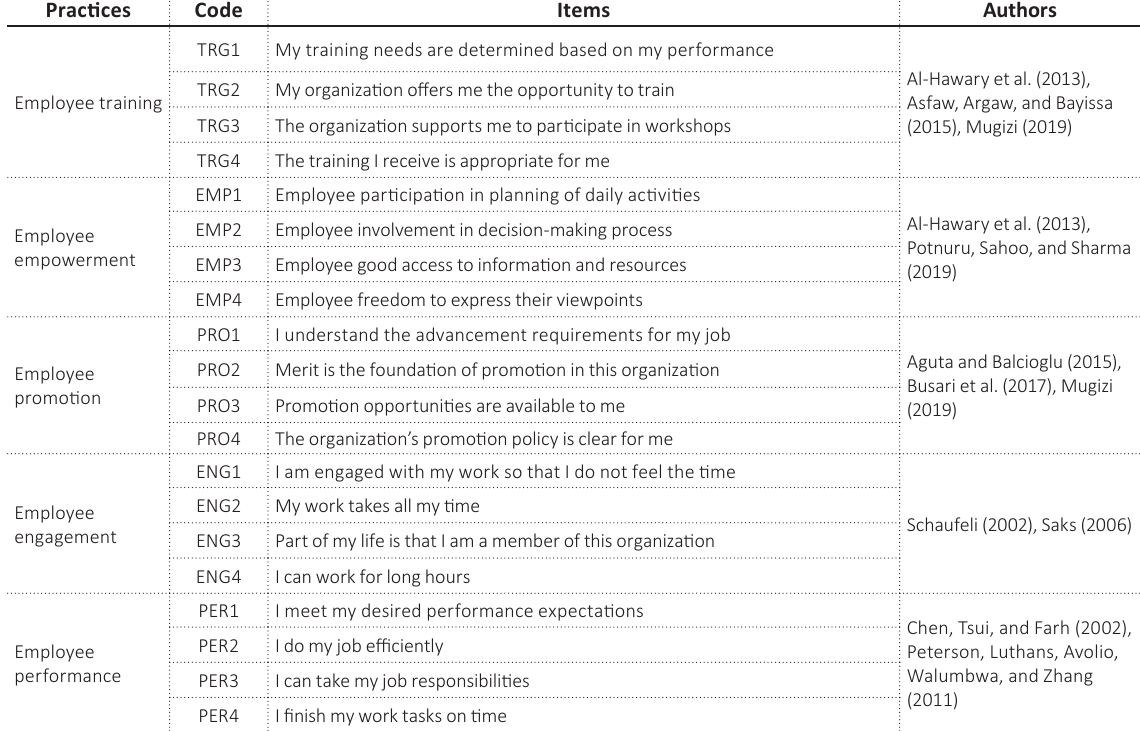
Table 2. Questionnaire